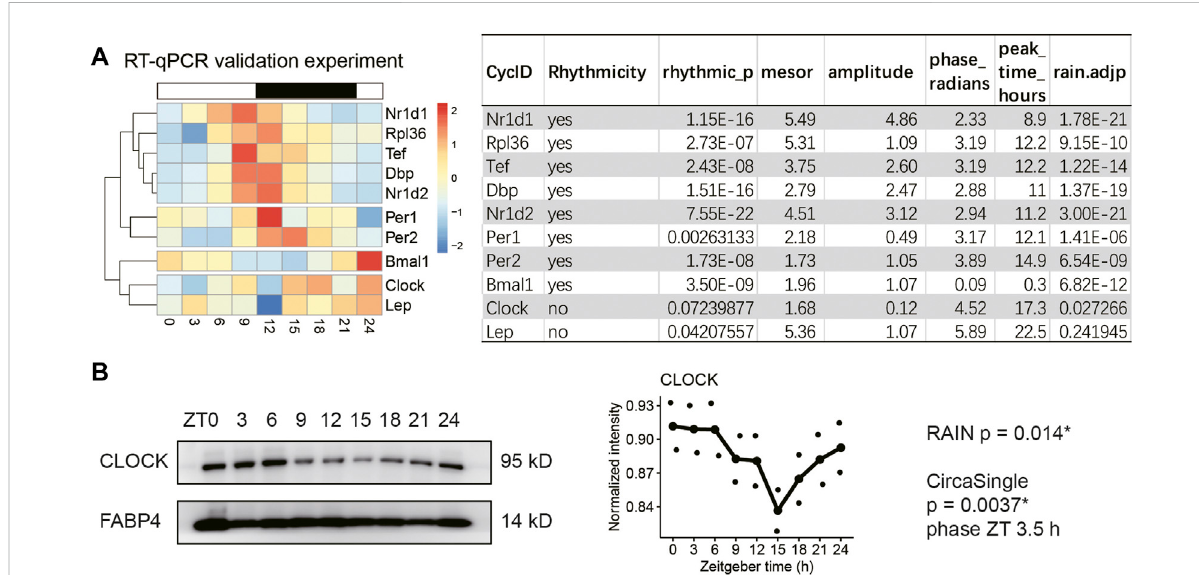
FIGURE 3 CLOCK protein exhibits robust rhythm despite loss of transcript rhythm in the adipose tissue of obese mice. Visceral adipose tissue (VAT) samples were collected every three hours for a complete 24-hour diurnal cycle in two different cohorts of male diet-induced obese mice. Mice had been fed HFD for 30 weeks. (A) Realtime quantitative PCR analysis of selected genes in VAT ( n = 2 mice per time point for nine time points, repeated three times). (B) Representative immunoblots ofCLOCKand FABP4 (loading control) proteins in theVAT from male obese mice ( n = 2 mice